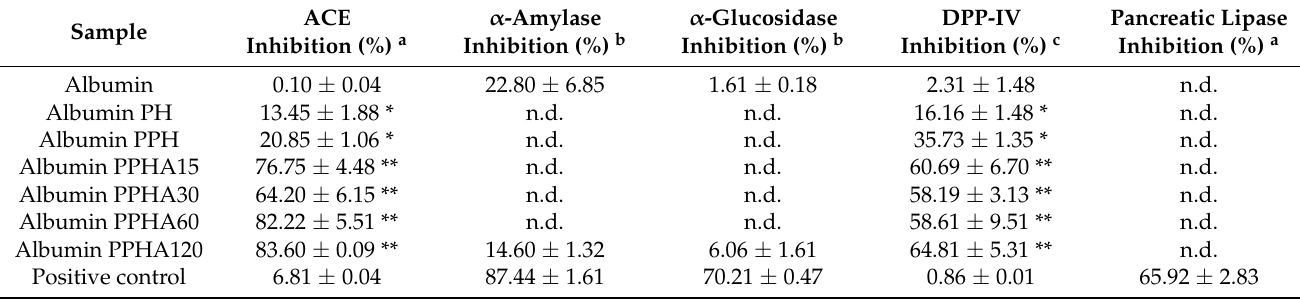
Table 2. In vitro anti-hypertensive and anti-diabetic activities of pajuro albumin-derived hydrolyzates obtained by hydroly- sis with pepsin (PH), hydrolysis with pepsin and pancreatin (PPH), and hydrolysis with pepsin, pancreatin, and Alcalase for 15 min (PPHA15), 30 min (PPHA30), 60 min (PPHA60) and 120 min